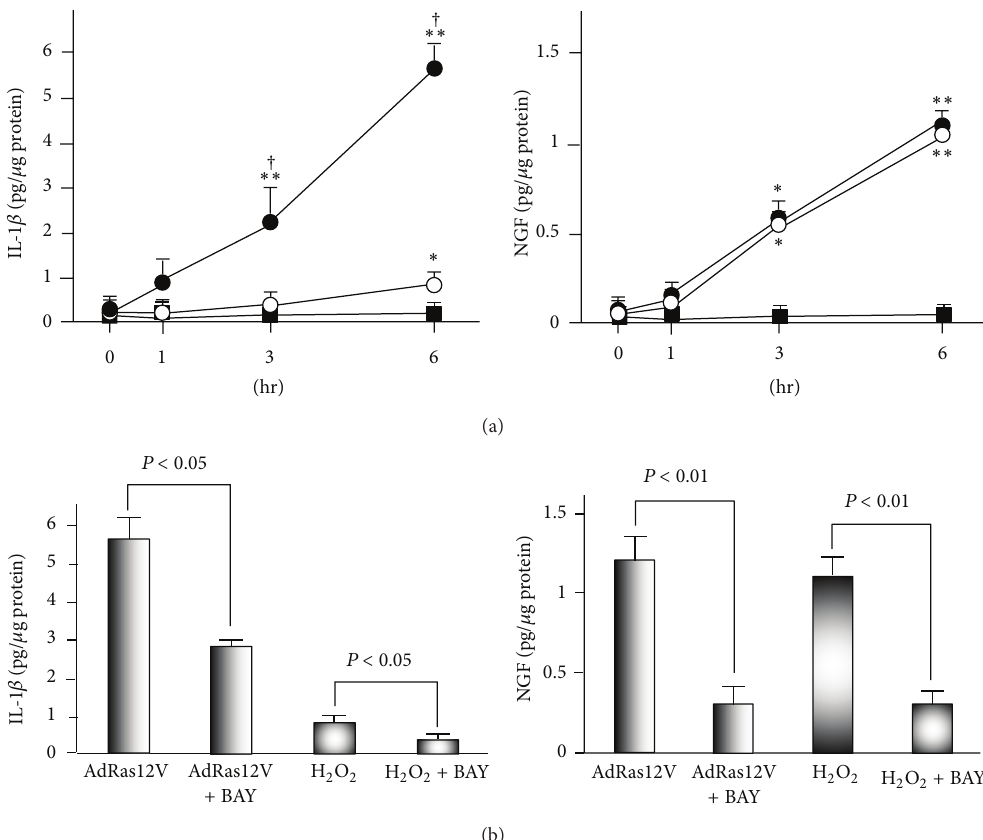
Figure 4: The expression of IL-1 𝛽 and NGF proteins in HUVECs treated with AdRas12V or H 2 O 2 . (a) Time course of the accumulation of IL-1 𝛽 and NGF in the culture media. HUVECs were infected with AdGFP (closed squares) or AdRas12V (closed circles) or treated with H 2 O 2 (open circles). After 1 week, HUVECs were washed with PBS, and medium was replaced with serum free Dulbecco’s modified Eagle medium (DMEM). HUVECs were incubated for the indicated periods, and culture media were collected for ELISA. ∗ and ∗∗ : 𝑃 < 0.05 and 𝑃 < 0.01 , respectively, versus AdGFP infection at each time point. † : 𝑃 < 0.05 versus H 2 O 2 treatment at each time point ( 𝑛 = 6 per group). (b) The effect of BAY11-7082 on cytokine production. Experiments were performed as in (a). In addition, some HUVECs were preincubated with 10 𝜇 mol/L of BAY11-7082 (Bay) for 2hrs and then washed with PBS. The medium was replaced with serum free DMEM. HUVECs were then incubated for 6hrs in the presence or absence of Bay ( 𝑛 = 6 per